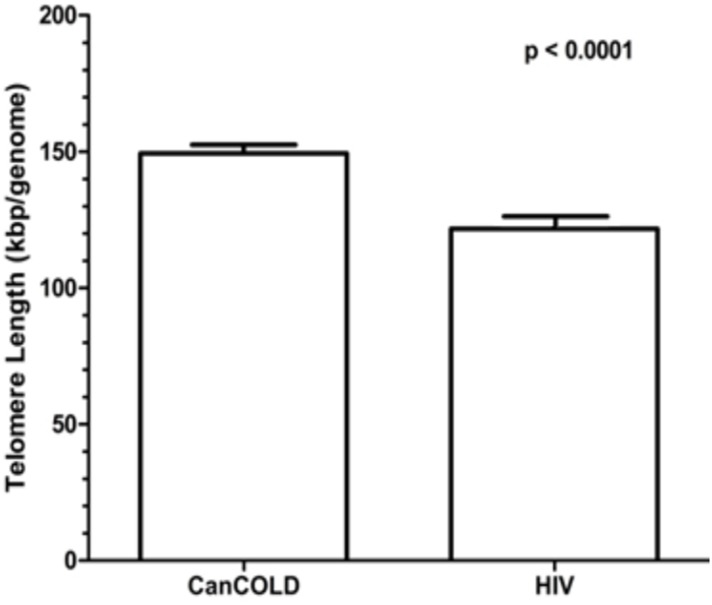
Absolute leukocyte telomere length differences between HIV-infected and non-HIV-infected individuals.Differences in the mean aTL between the CanCOLD and HIV populations after adjustment for age, gender, BMI, smoking pack-years, and FEV1%Pred. The aTL of the CanCOLD population was significantly different from that of the HIV population (p<0.0001). Error bars represent the standard error.